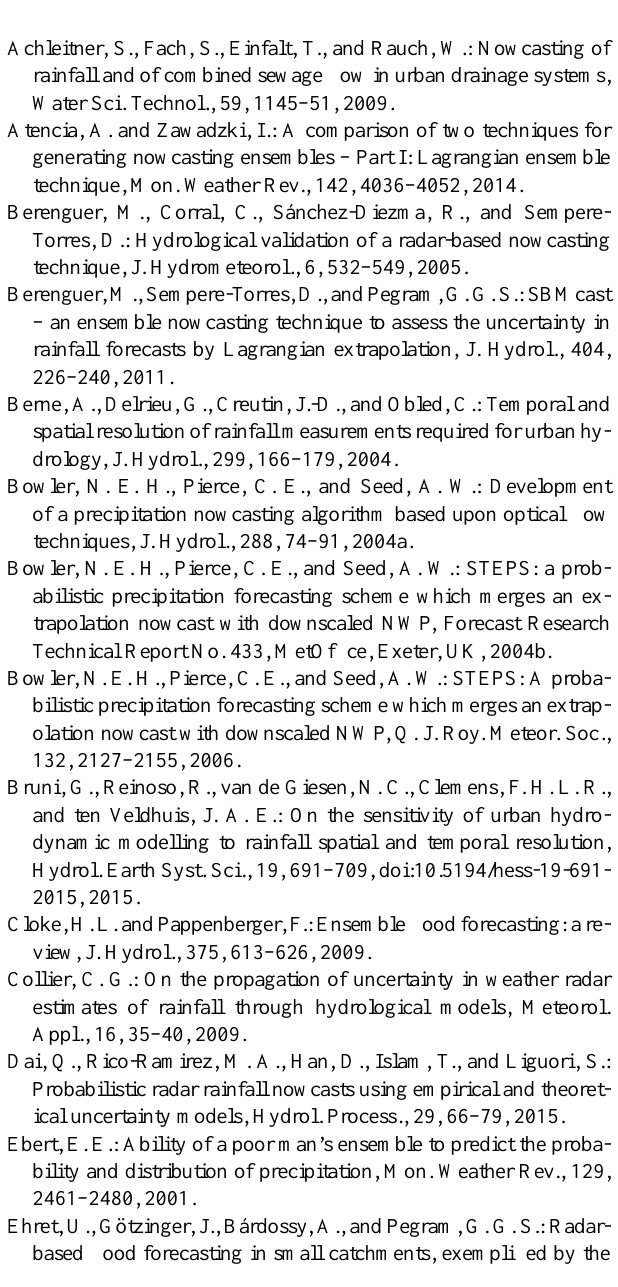
Figueras i Ventura, J. and Tabary, P.: The new French